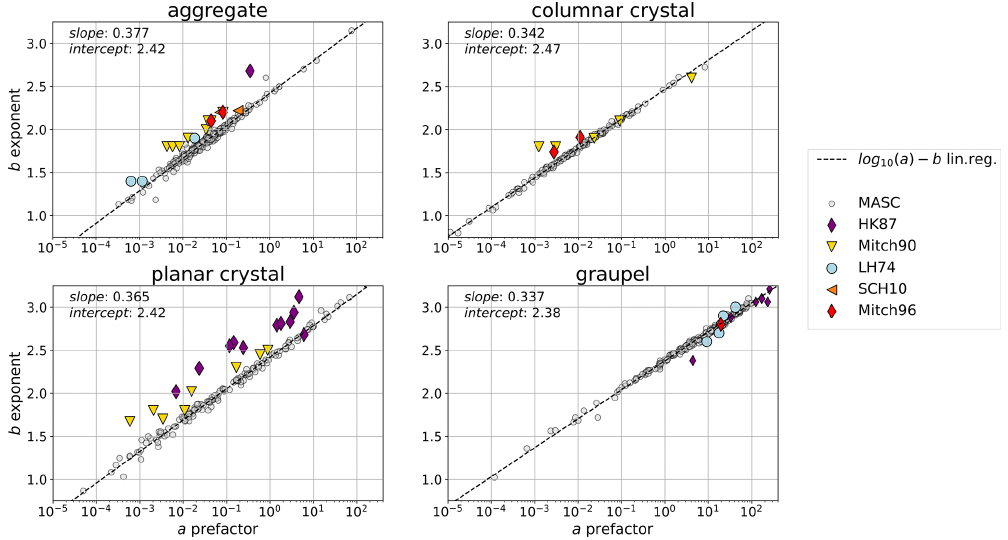
Figure B3. Relation between exponent and prefactor of mass–size relations for different particle types, computed using MASCDB; see Grazioli et al. (2022) and acronyms